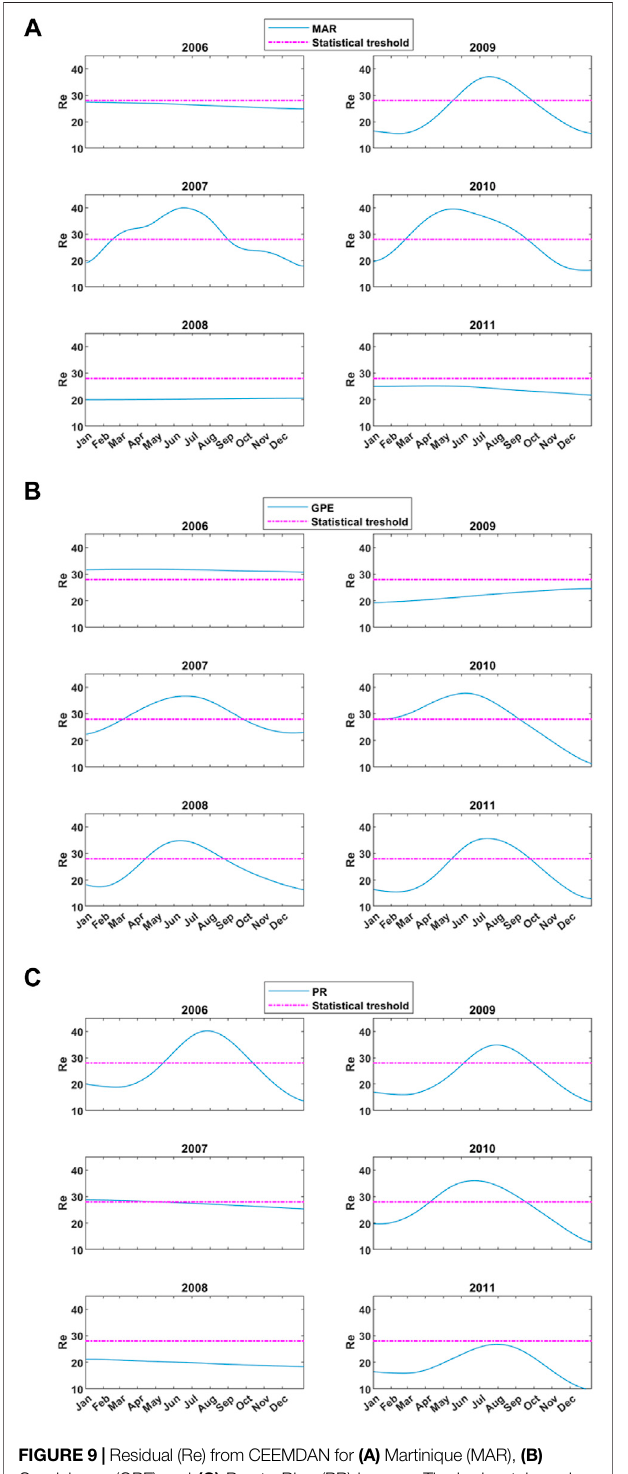
Frontiers in Environmental Science |